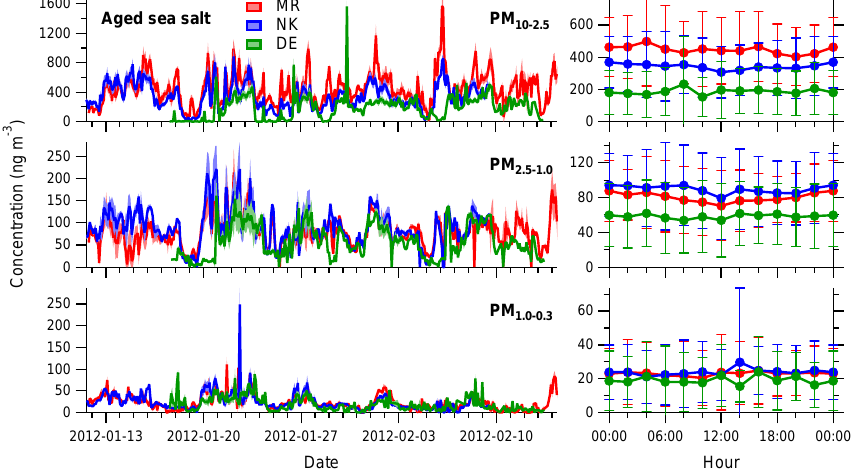
Figure 9. Time series (left) and diurnal variations (right) of the aged sea salt factor at MR, NK and DE for PM 10–2 . 5 , PM 2 . 5–1 . 0 and PM 1 . 0–0 . 3 . Time series show the mean of all good solutions ± 1SD as shaded areas. Diurnals show the mean of the time series ± 1SD as whiskers, with the hour being the start of a 2h sampling period (00:00UTC means sampling from 00:00 to